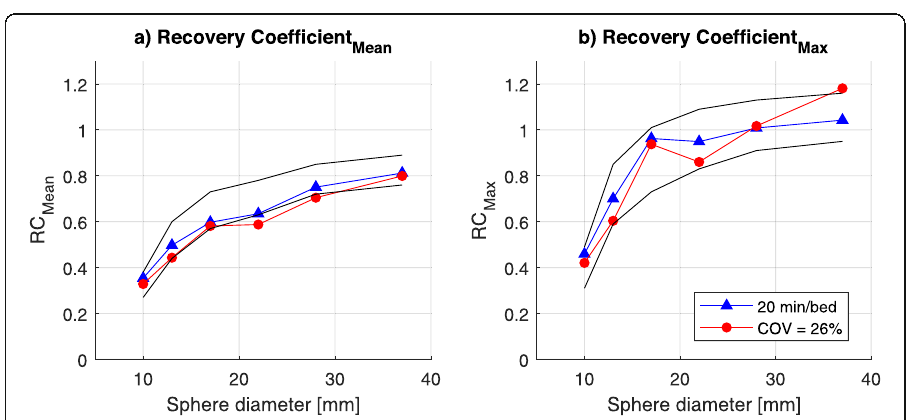
Fig. 3 a RC mean and b RC max values for all spheres for the PET reconstructions of 68 Ga scan of 20 min/bed and COV = 26% (100 s/bed), compared to EARL minimum and maximum accreditation specifications